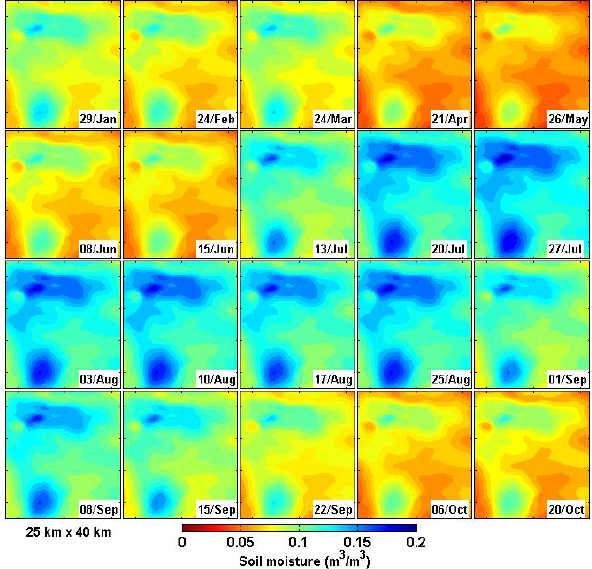
Fig. 6. The modeled soil moisture maps from 2012 using the rela- tionship in Eq. (7). The same overall trend is preserved when the mean soil moisture is constrained. The pattern is consistent because the mean f parameter was used to reproduce each map